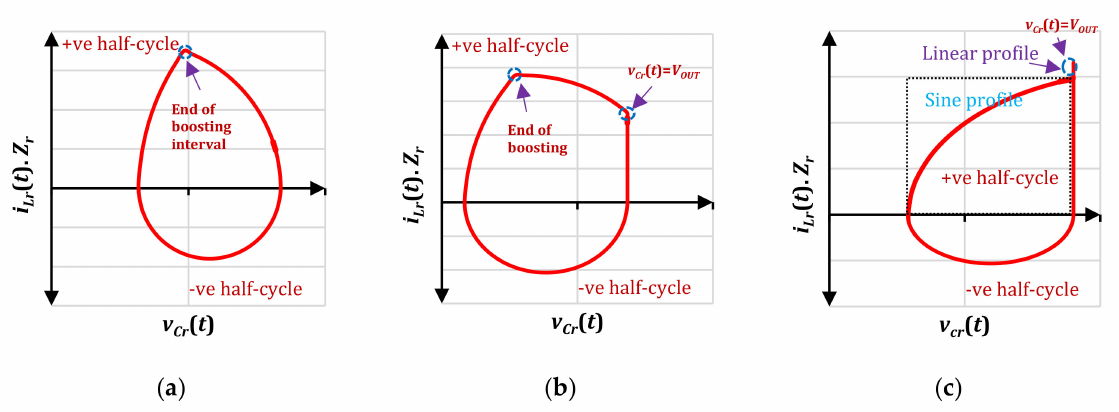
Figure 5. Trajectory curves of the converter state variables for the three possible scenarios in the boost - SRC conditions.